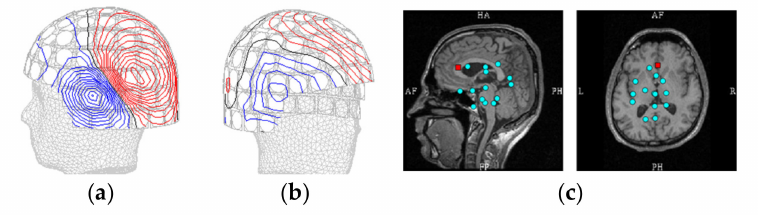
Figure 7. ( a ) Isocontour maps at peak signal of Figure 5a. ( b ) Corresponding map at peak signal of Figure 6a. ( c ) Locations of the 15 dipoles with lowest SNR; the red box points to the source dipole of Figure